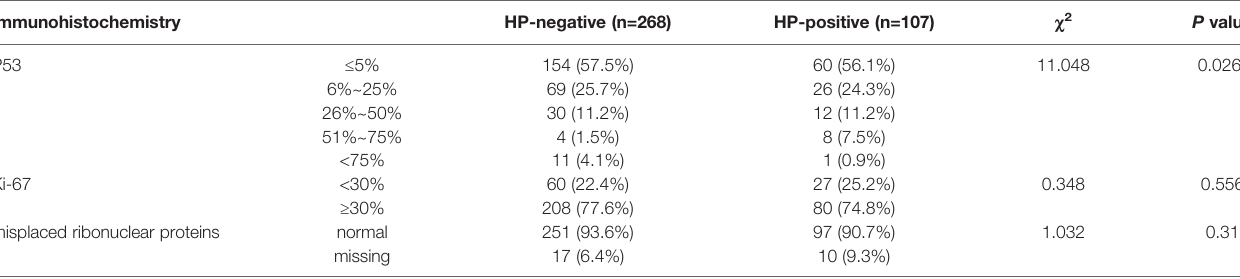
TABLE 5 | The effect of HP infection on the results of immunohistochemistry with c 2 test.